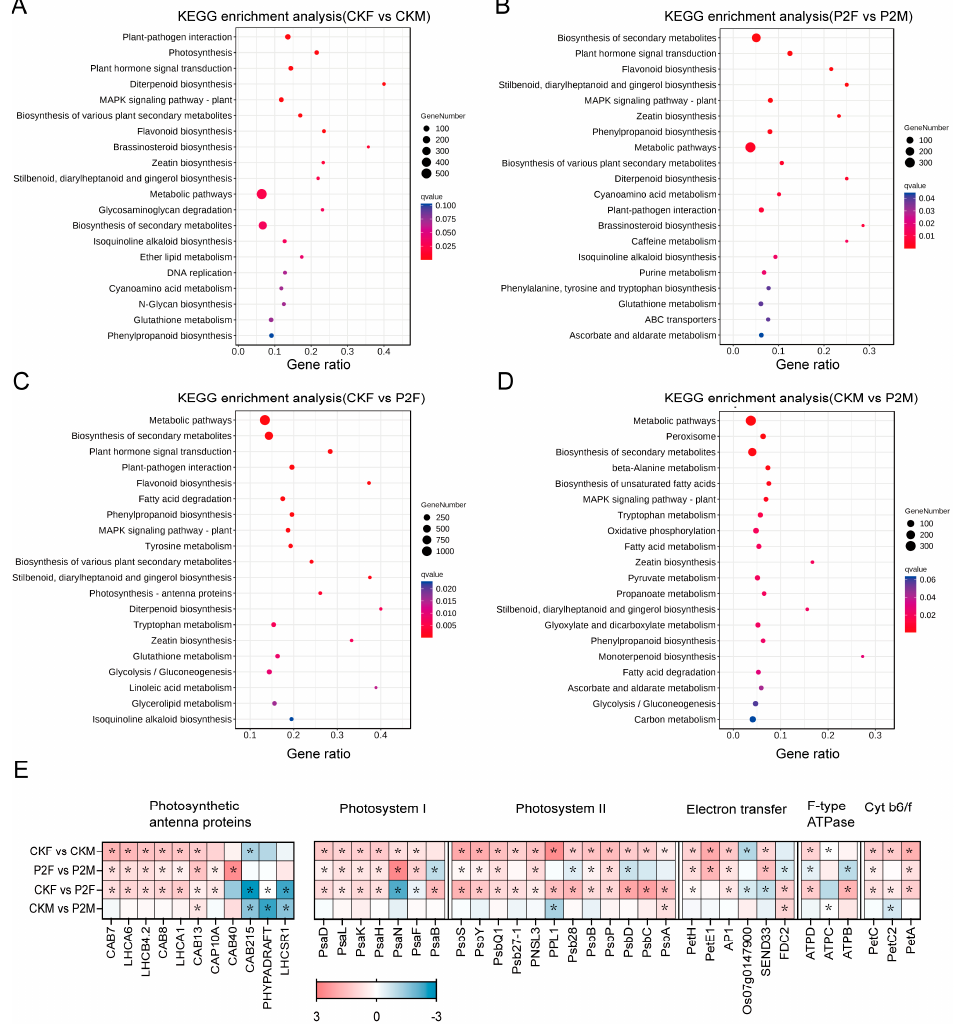
Figure 7. Transcriptome di ff erences between L. cubeba female and male leaves under control and Pb treatments: ( A – D ) The top 20 pathways of the KEGG enrichment analysis of DEGs in CKF vs. CKM ( A ), P2F vs. P2M ( B ), CKF vs. P2F ( C ), and CKM vs. P2M ( D ) induced by Pb stress; and ( E ) expres-